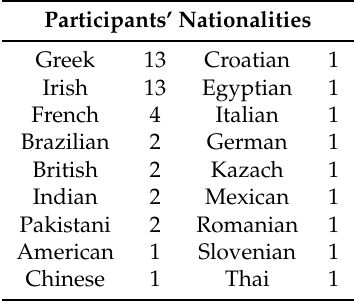
Table 2. Distribution of participants’ nationalities.